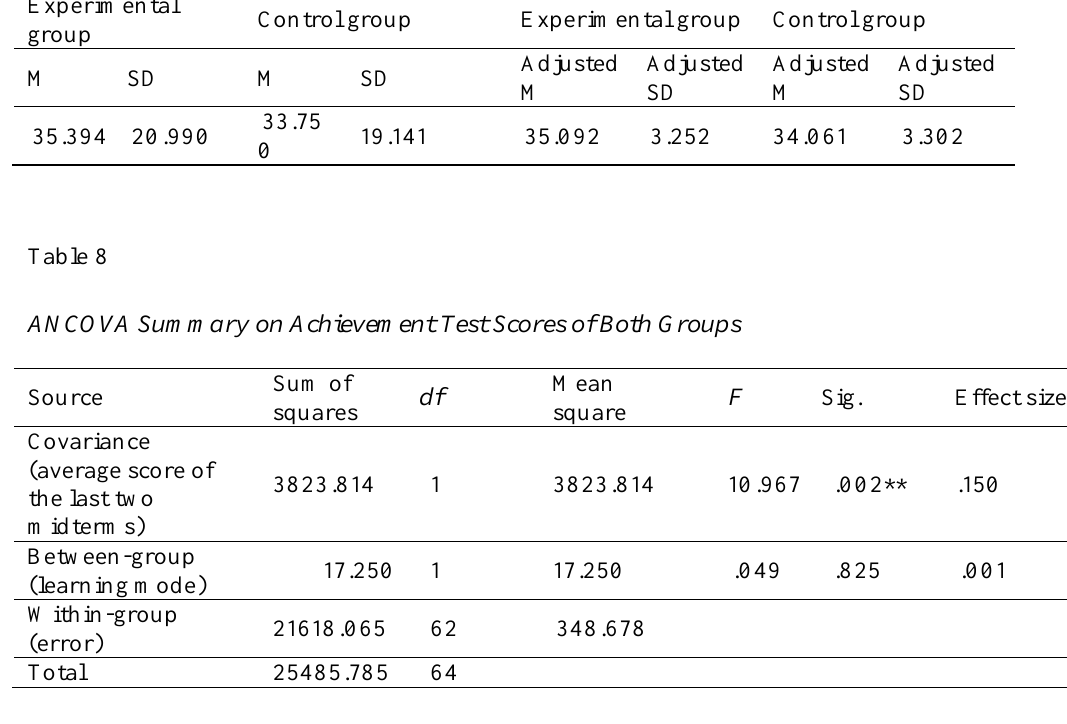
Descriptive Statistics for Achievement Test Scores of Both Groups Experimental Control group Experimental group group